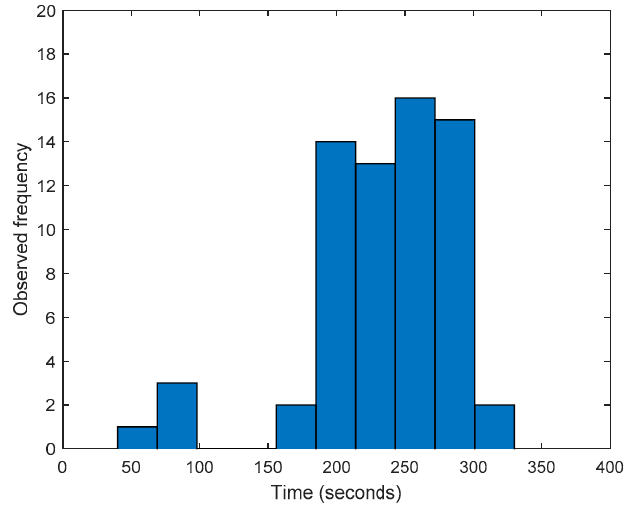
Figure 7. Histogram of recorded admission times.